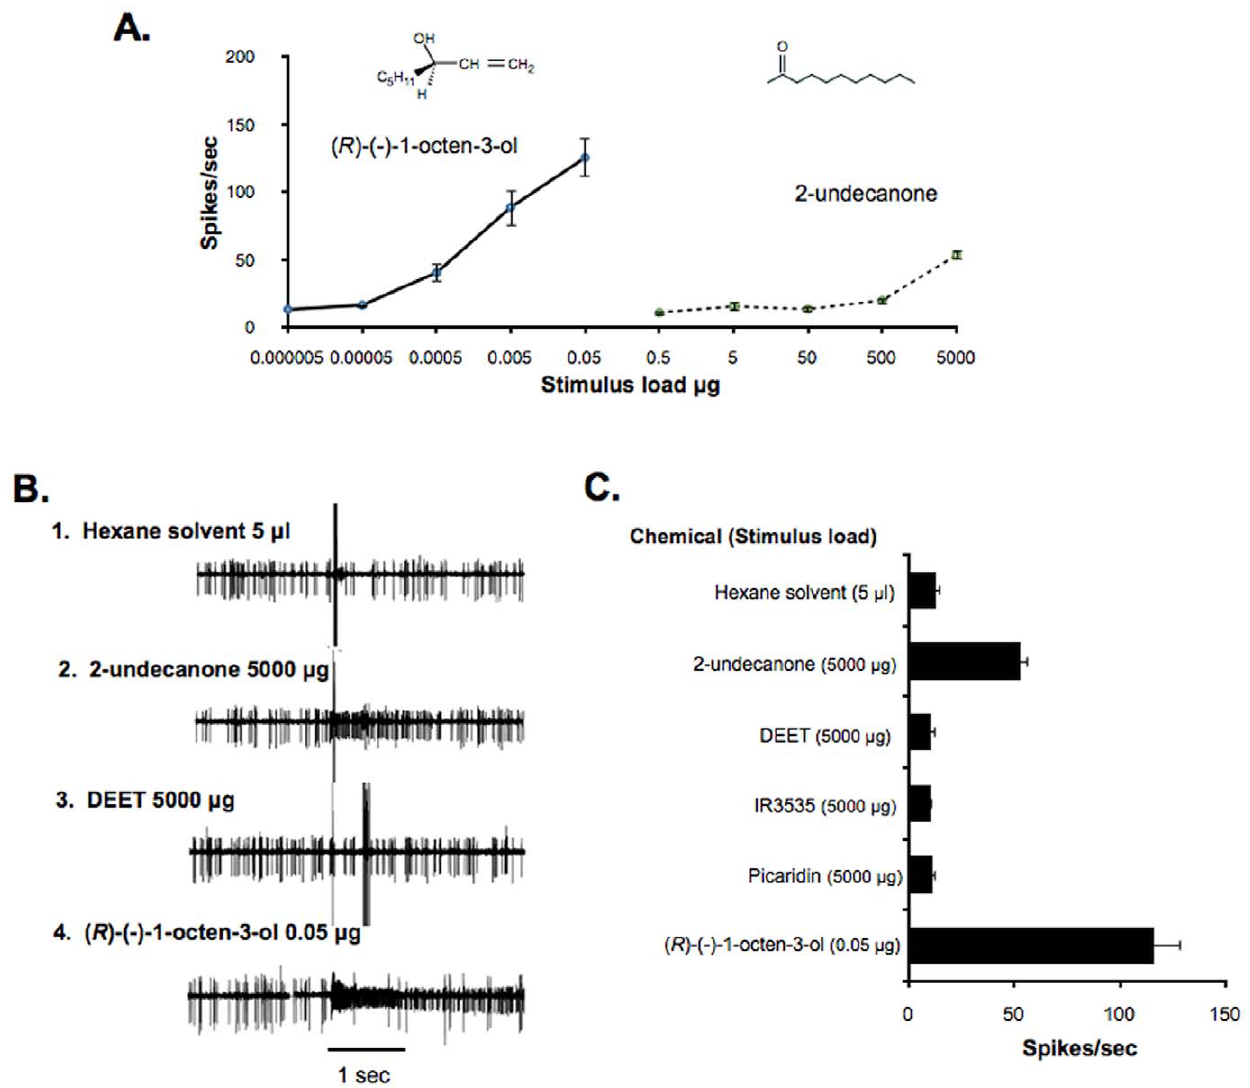
Figure3.2-Undecanone,aknownrepellent,activatesthe‘‘C’’neuron. (A)Dose-responserelationshipfromthe‘‘C’’neuroninmaxillarypalpsensillaof female Ae.aegypti inresponsetoincreasingdosesof( R )-( 2